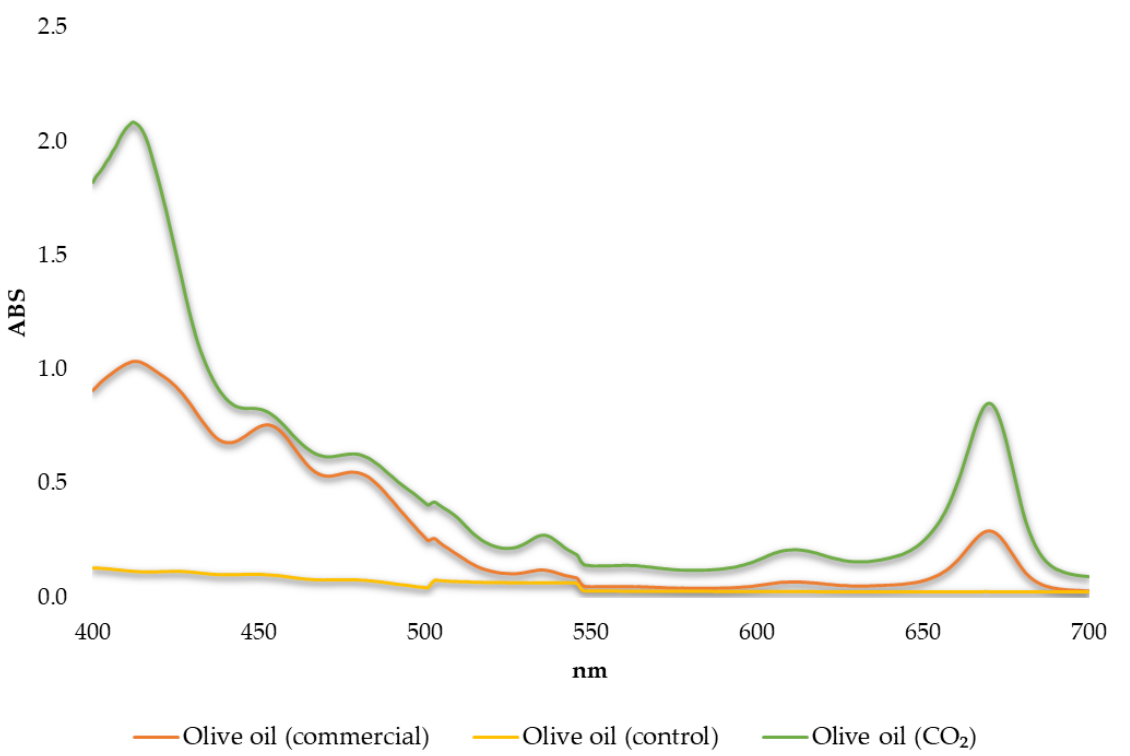
Figure 5. Absorption spectra obtained for chlorophylls (670 nm) and carotenoids (470 nm) in different olive oils.